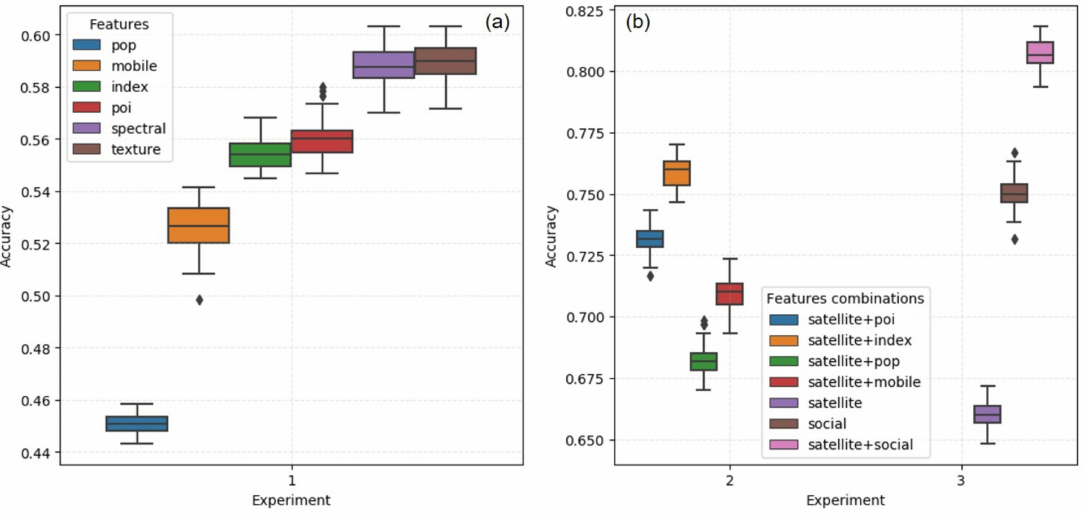
Figure 14. Accuracy of different feature combinations for Level I (run 1000 times, 2800 training, and 600 testing samples): ( a ) single data source; and ( b ) features combinations.